Question: Which visualization type does this figure use?
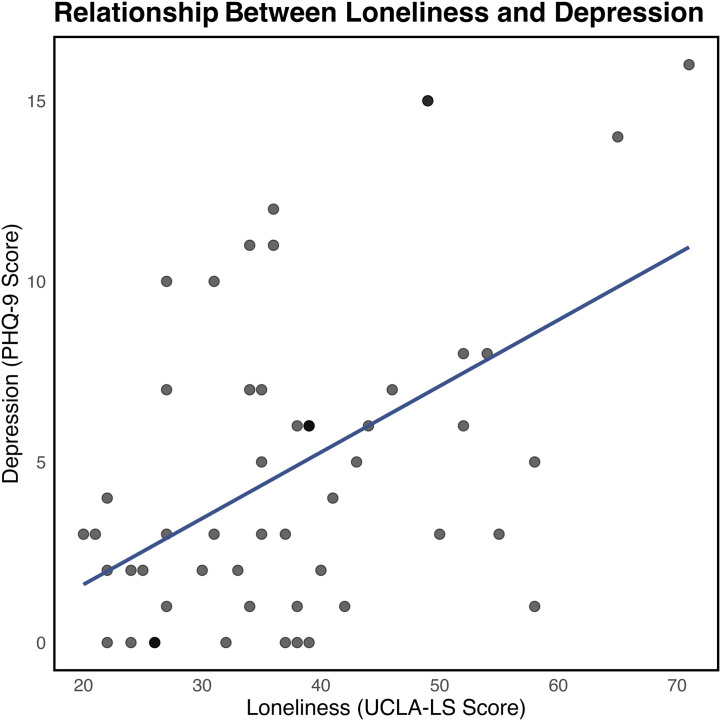
Answer: scatter